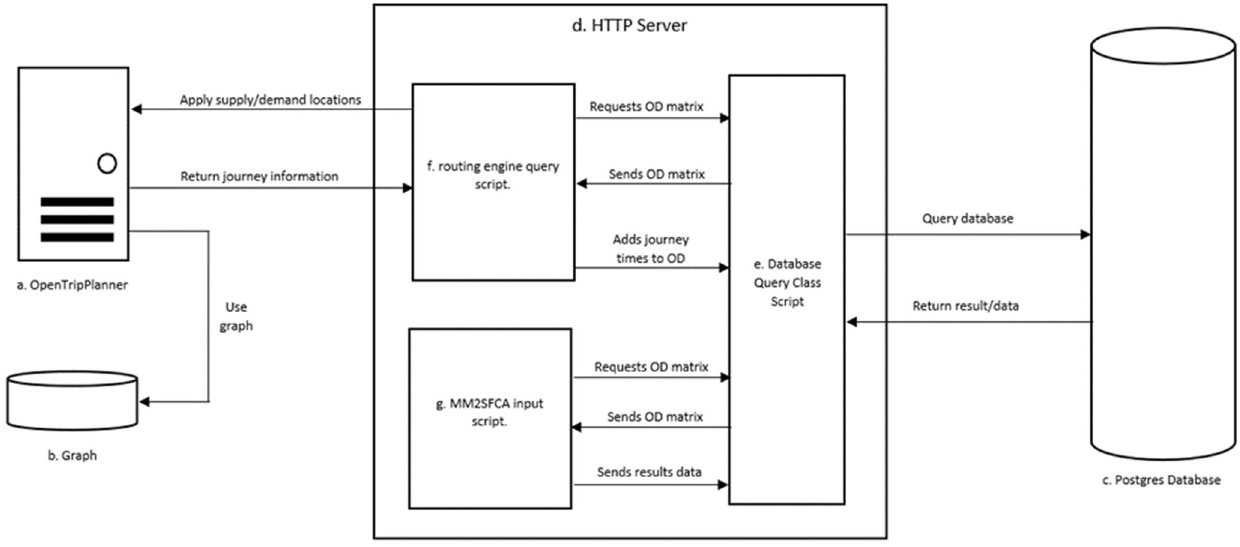
Figure 5. Computing environment and infrastructure used to execute FCA